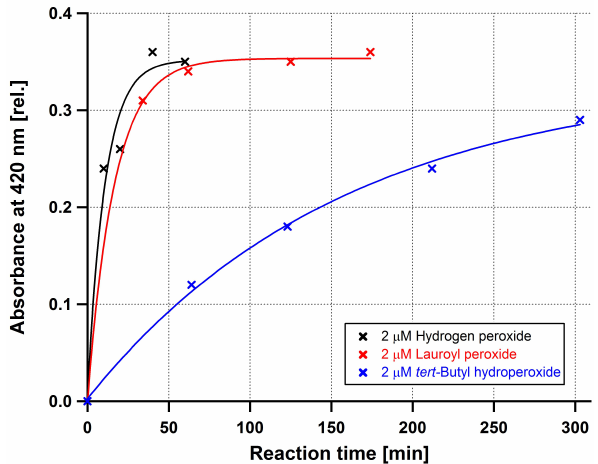
Fig. 4. Average of calibration curves from hydrogen peroxide, ben- zoyl peroxide, lauroyl peroxide and peracetic acid. Measurements were blank corrected and absorbance values averaged for each con- centration. Error bars represent ± standard deviation. The green area illustrates the 95% confidence interval. The slope of this curve was used to calculate peroxide concentrations from the smog cham- ber experiments.